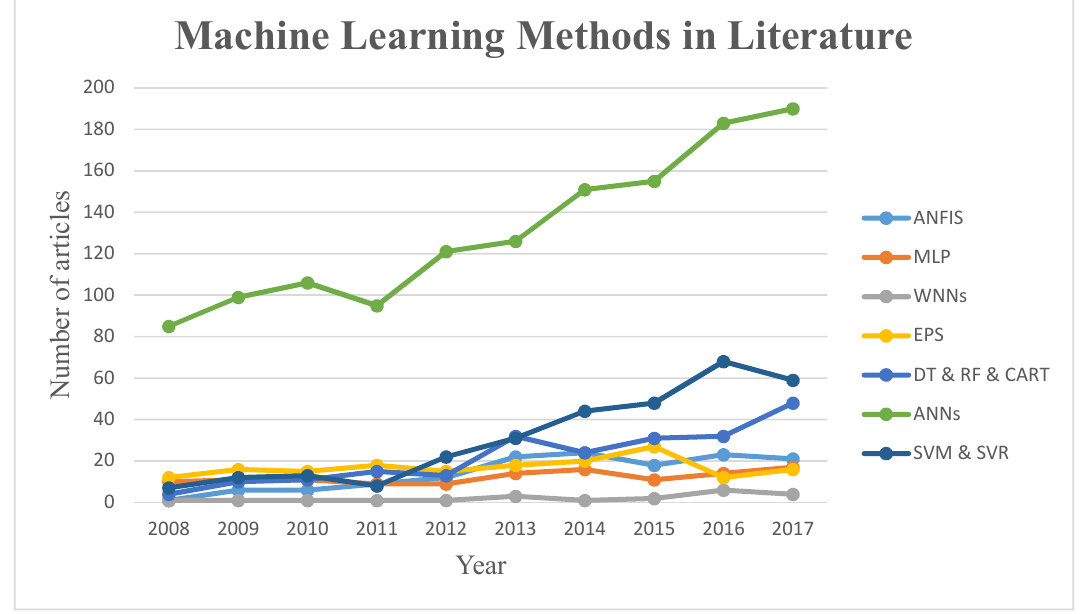
Figure 3. Major ML methods used for flood prediction in the literature. Reference year: 2008 (source: Scopus).